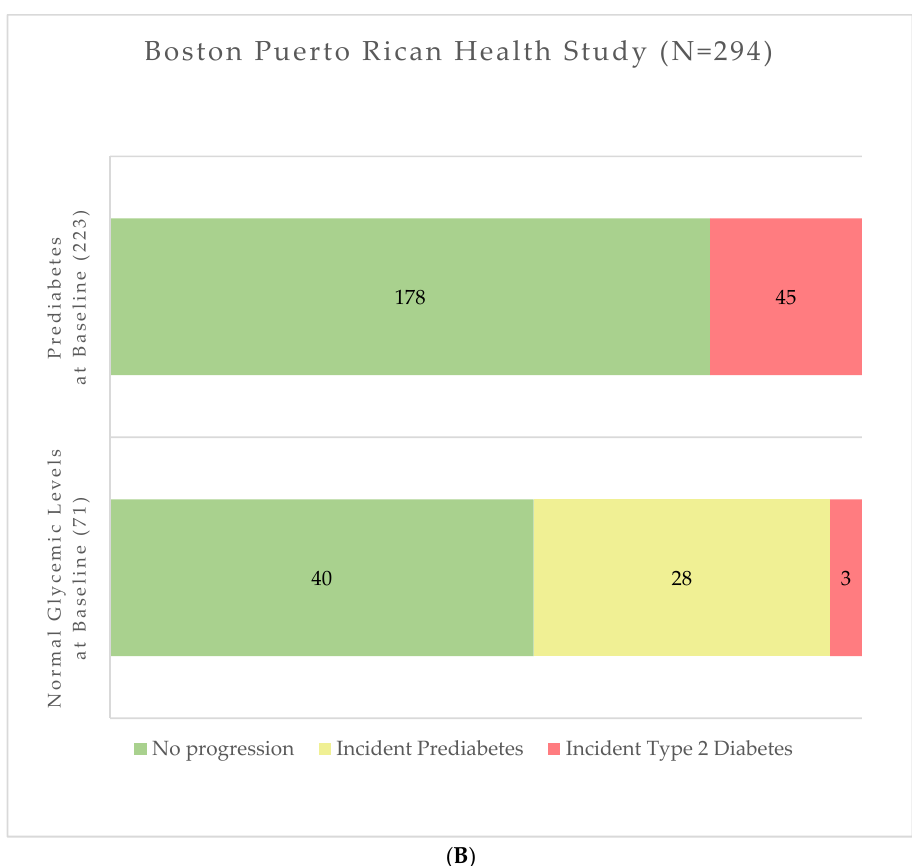
Figure 1. ( A ) Distribution of San Juan Overweight Adult Study (SOALS) participants at follow-up, according to baseline glycemic levels. ( B ) Distribution of Boston Puerto Rican Health Study (BPRHS) participants at follow-up, according to baseline glycemic levels.